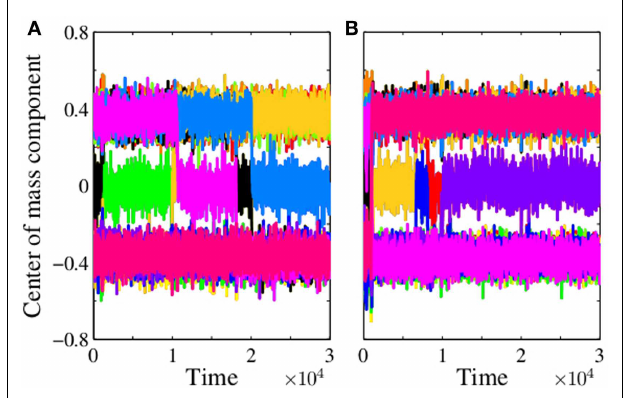
FIGURE 4 | Reorganization of the 12-group architecture with self .The figures displays the time series of the components of the center of mass vector obtained from simulations for an influx probability p = 0.076 when at t = 0 one node (A) or 10 nodes (B) of the hole group S 10 are permanently occupied. Each of the 12 components is drawn with a different color.They are plotted one after another, only the last printed color is visible.The trajectories mainly fluctuate around ± 0.4 and zero. Jumps between these values indicate changes of the determinant bits associated with a reorganization of the architecture. For one self node (A) we see five jumps and for t (cid:39) 2 × 10 4 a stationary state is reached. For 10 self nodes (B) , after a few jumps, the stationary state is already reached for t (cid:39) 10 4 , obviously the impact of 10 self nodes is stronger than the impact of one. A closer